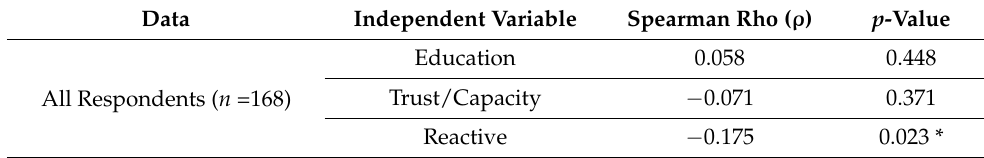
Table 7. Independent variable Spearman correlations with environmental deliberative